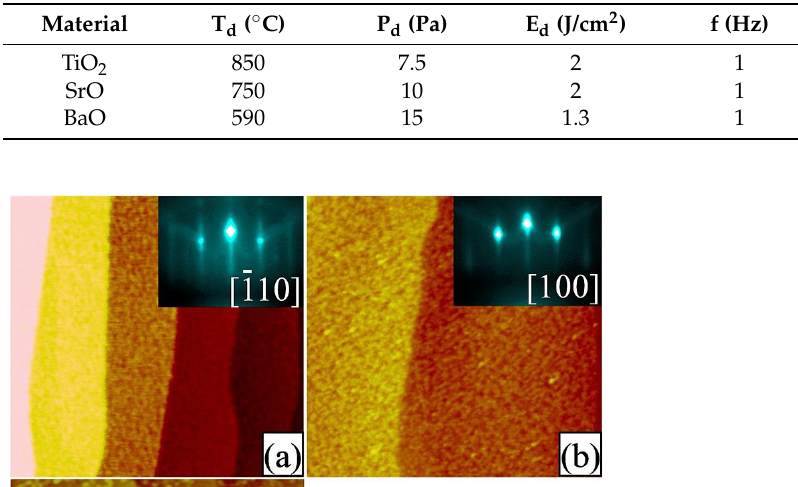
Figure 6. AFM topographic images and the corresponding RHEED patterns of ( a ) ~1 monolayer TiO 2 deposited on (110) NdGaO 3 substrate annealed for 1 h at 1000 °C in O 2 flow (50 L/h); ( b ) ~1 monolayer SrO deposited on (001) NdGaO 3 substrate chemically etched in m-BHF solution and then annealed for 2 h at 1000 °C, in O 2 flow (200 L/h); ( c ) SrO (the same amount of material as in ( b )) deposited on (001) NdGaO 3 substrate annealed for 2 h at 1000 °C, in O 2 flow (200 L/h); SrO islands of about 0.26 nm height formed in this case on substrate terraces (c pc height), as shown by the line scan from ( d ). AFM scan size: ( a ) 1.5 × 1.5 μm 2 , ( b ) 0.75 × 0.75 μm 2 , and ( c ) 2 × 2 μm 2 . SrO was next deposited on an m-BHF etched (001) NdGaO 3 surface. The RHEED